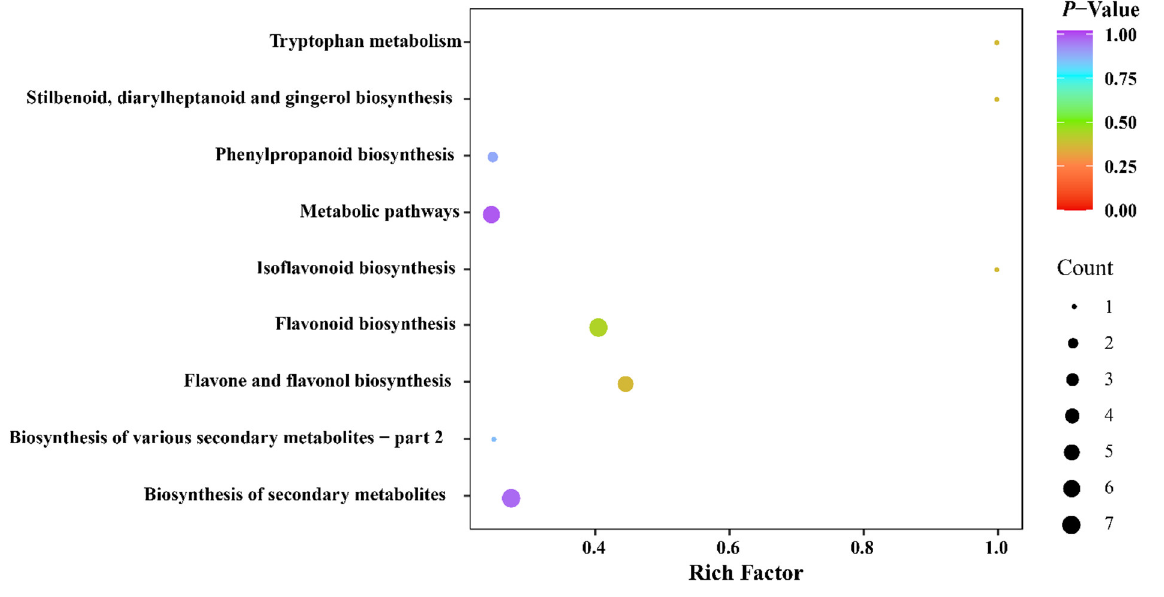
Figure 7. Metabolic pathway enrichment analysis for the NYN and YN groups differentially accumulated metabolites.